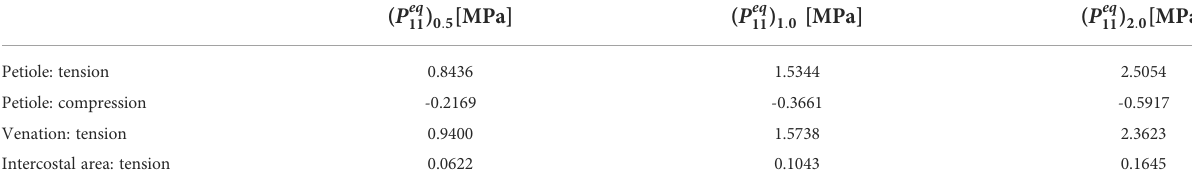
TABLE 1 Equilibrium state of each fi xed